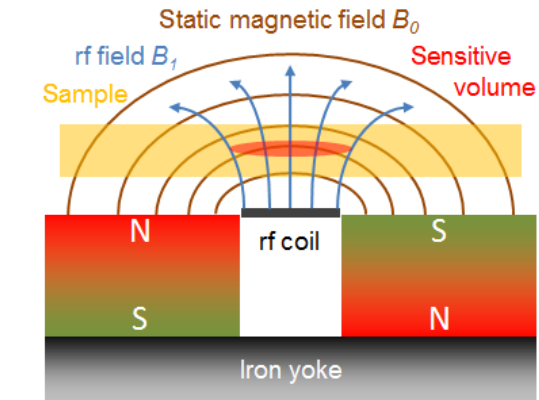
Figure 1. Schematic of the single-sided NMR